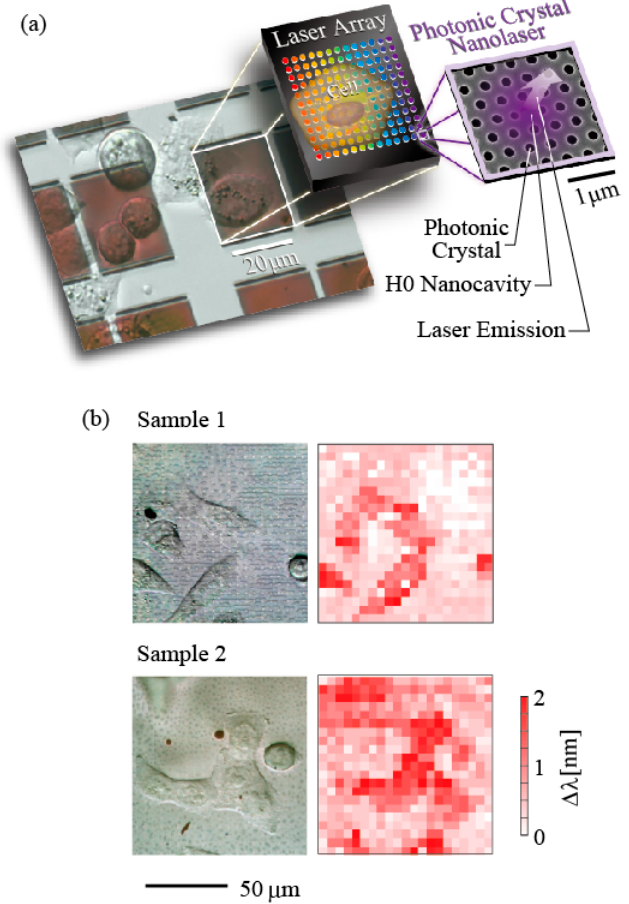
Figure 6. Live cell imaging using nanolaser array. ( a ) Concept of imaging. ( b ) Optical microscopy of cells for two samples and image by 21 × 21 nanolaser array.